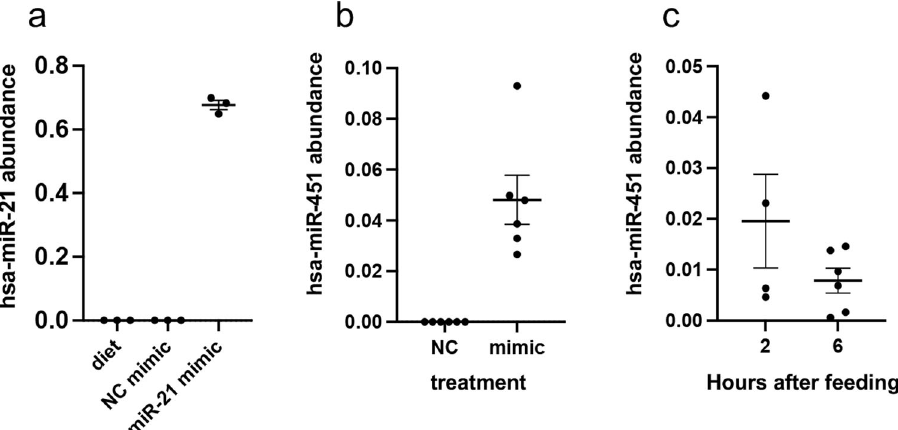
Fig. 3 Human miRNA mimics are transported into the mosquito fat body. RT-qPCR detection of hsa-miR-21-5p a 12 h after feeding, b hsa-miR-451a 12 h after feeding and c 2 and 6 h after feeding, on arti fi cial diet spiked with its mimic. NC, negative control mimic. Two separate experiments were performed; each point represents the fat body of one mosquito. Ae. aegypti U6 non-coding small nuclear RNA was used as reference. Error bars represent standard error of the mean (SEM) in three or more biological replicates.